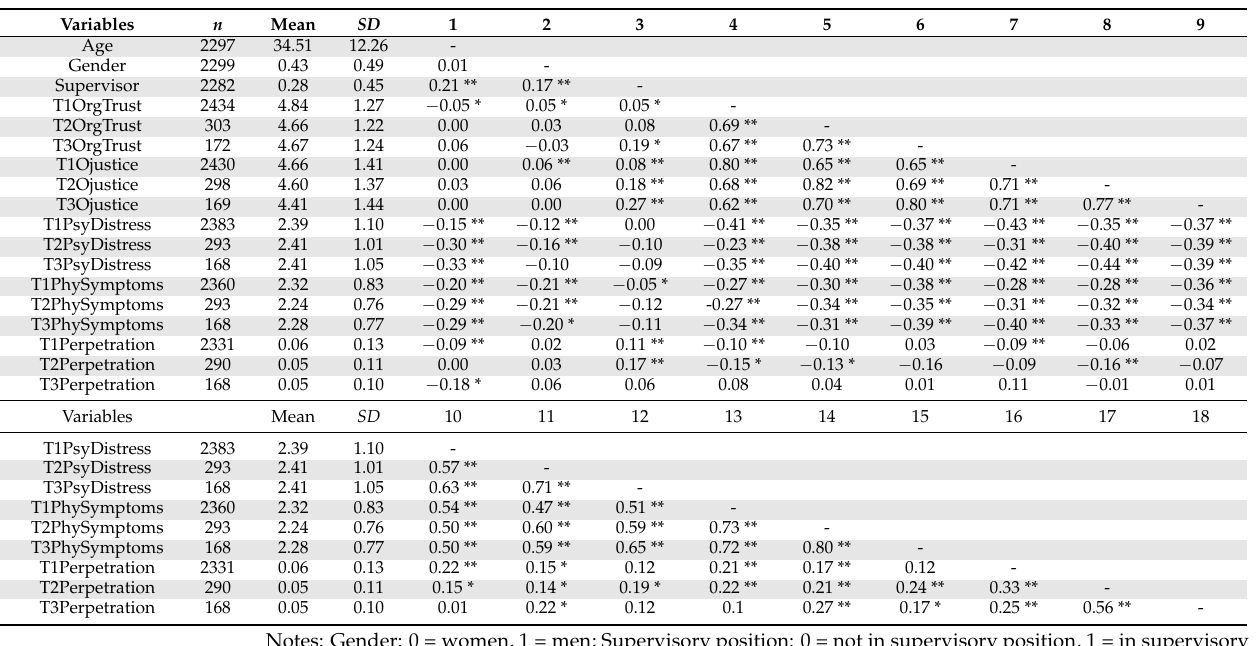
Table 3. Descriptives and